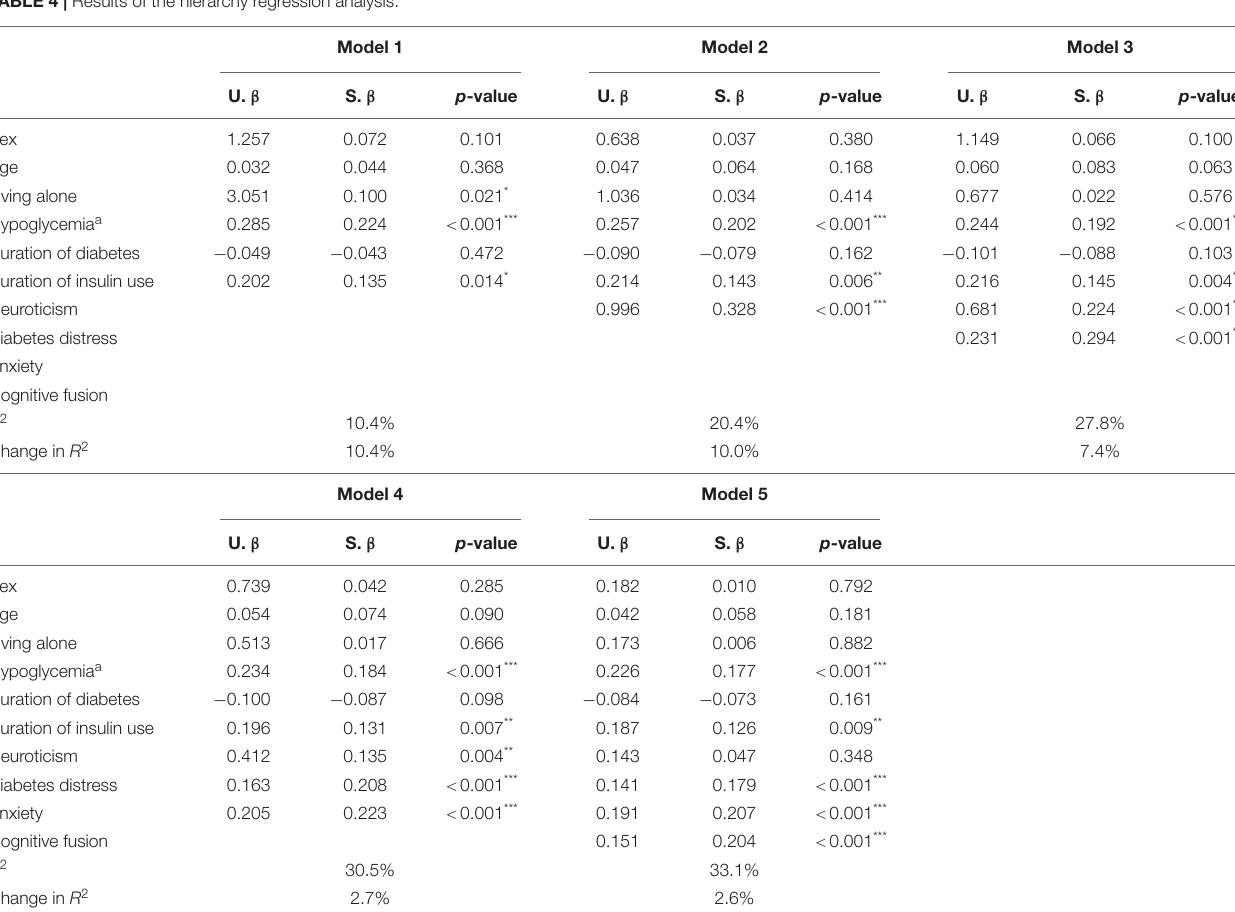
TABLE 4 | Results of the hierarchy regression